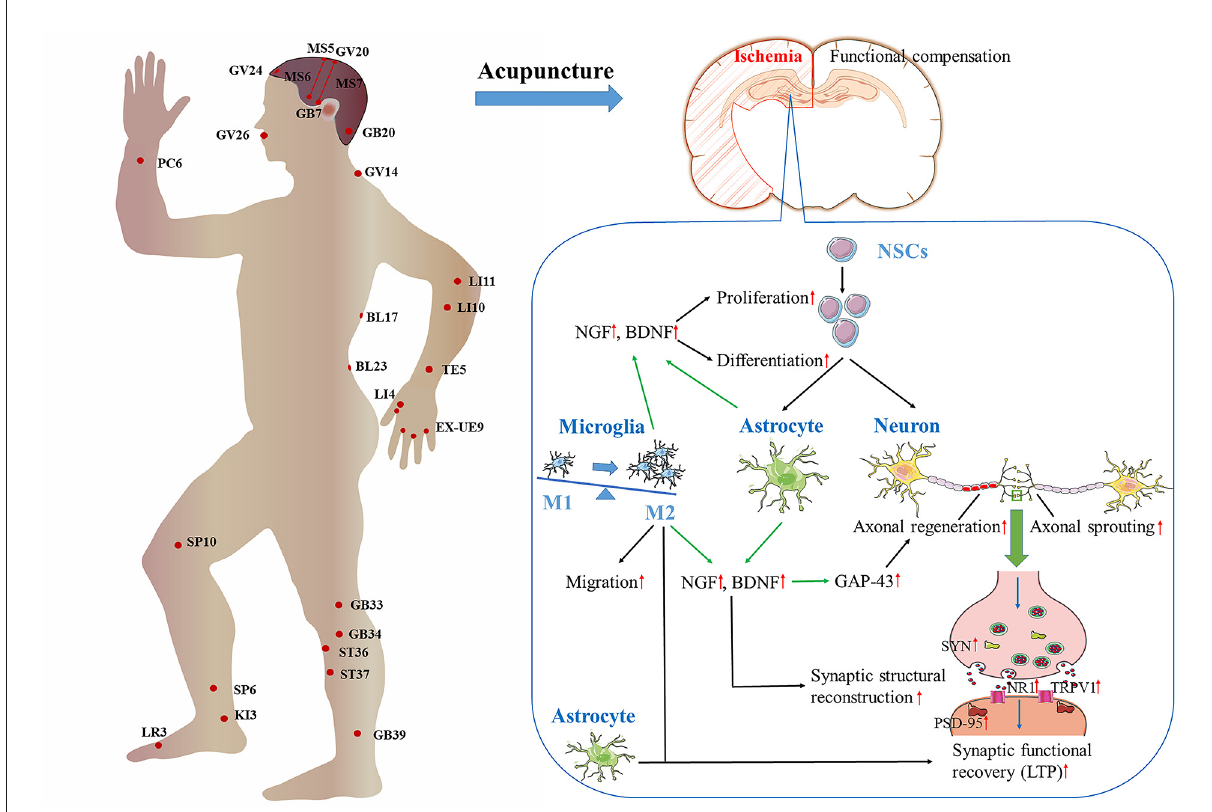
FIGURE2 Schematic representation showing the modulation of neuroplasticity by acupuncture after ischemic stroke by the promotion of functional compensation and structural plasticity. The data of acupoint selection and mechanism are derived from the mechanistic studies by using human and rodents. PC6, Neiguan ; GV26, Shuigo u; GV24, Shentin g; GV20, Baihui ; GB7, Qubin ; GB20, Fengchi ; GV14, Dazhui ; LI11, Quch i; LI10, Shousanli ; TE5, Waiguan ; LI4, Hegu ; GB33, Xiyangguan ; GB34, Yanglingquan ; ST36, Zusanli ; ST37, Shangjuxu ; GB39, Xuanzhong ; LR3, Taichong ; KI3, Taixi ; SP6, Sanyinjiao ; SP10, Xuehai ; EX-UE9, Baxie ; NSCs, neural stem cells; NGF, nerve growth factor; BDNF, brain-derived neurotrophic factor; GAP-43, growth associated protein-43; SYN, synaptophysin; NR1, N-methyl-d-aspartate receptor subtype 1; TRPV1, transient